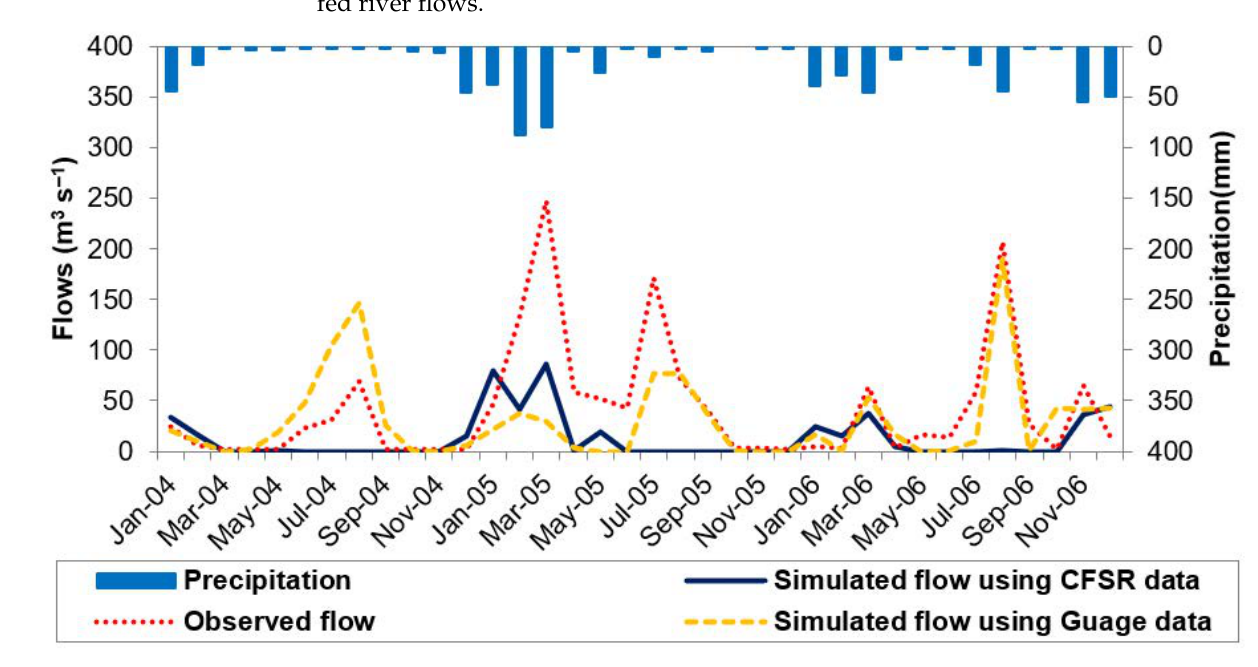
Figure 6. Runoff simulations using CFSR dataset.